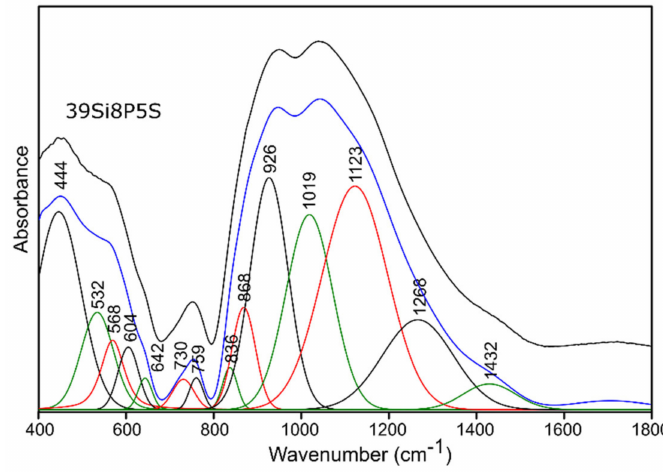
Figure 9. Deconvolution of the MIR spectra of the 39Si8P5S glass sample. Table 3. The positions of the peak centers of the deconvoluted MIR spectra of the pure and sulfur-doped silicate–phosphate glass samples in the particular ranges of wavenumbers, as well as the assignments of the bands to the appropriate vibrations.